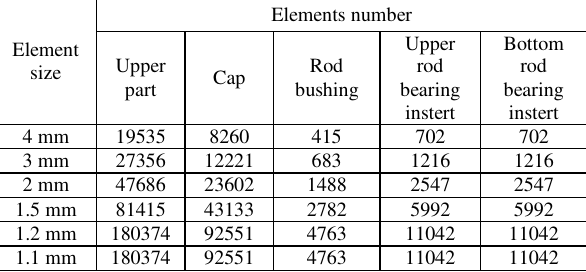
Table 3. Size and number of